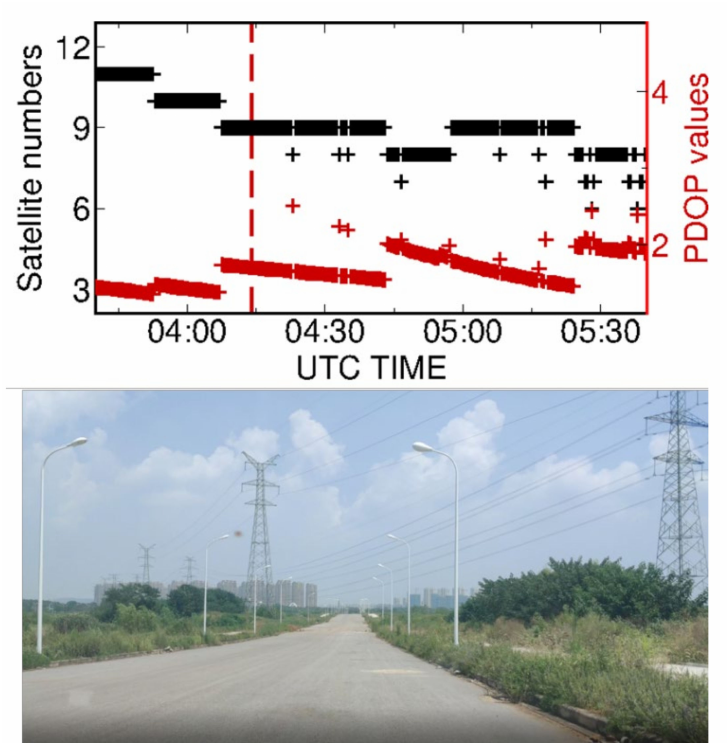
Figure 5. The top panel shows the satellite numbers and PDOP values during experiment period. The dotted red line marks the epoch when the vehicle started moving. The bottom panel is the snapshot of the experiment environment nearing to the high voltage overhead power